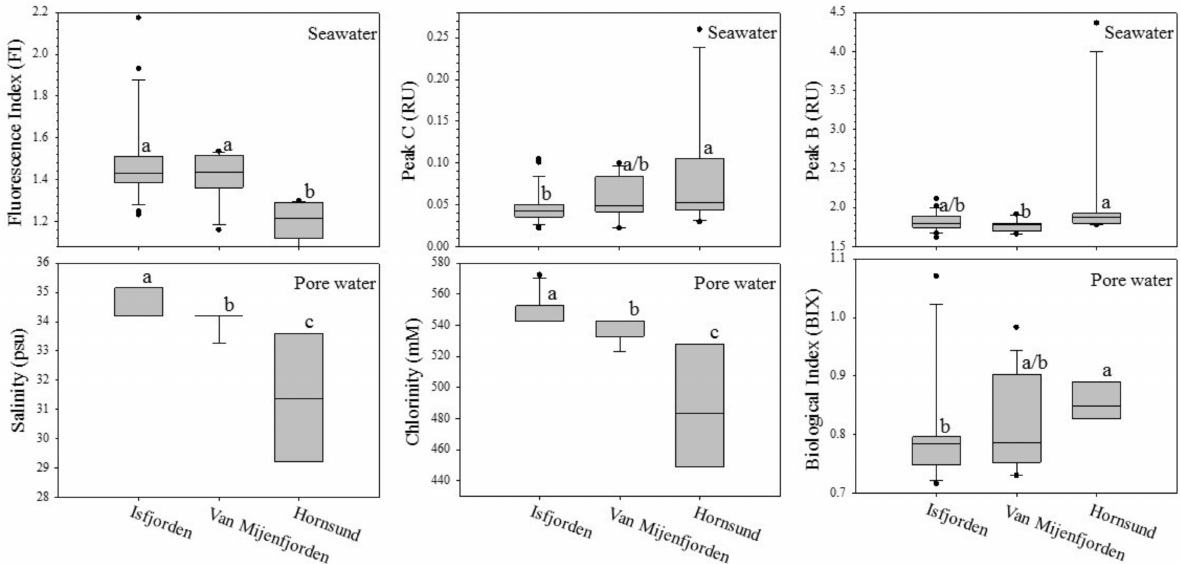
Figure 4. Cross-fjord comparison of dissolved organic matter (DOM) parameters in seawater (upper row) and pore water (lower row). Boxes with different alphabet letters are significantly different ( p < 0.05). Isfjorden is the north most and Hornsund is the south most among these three